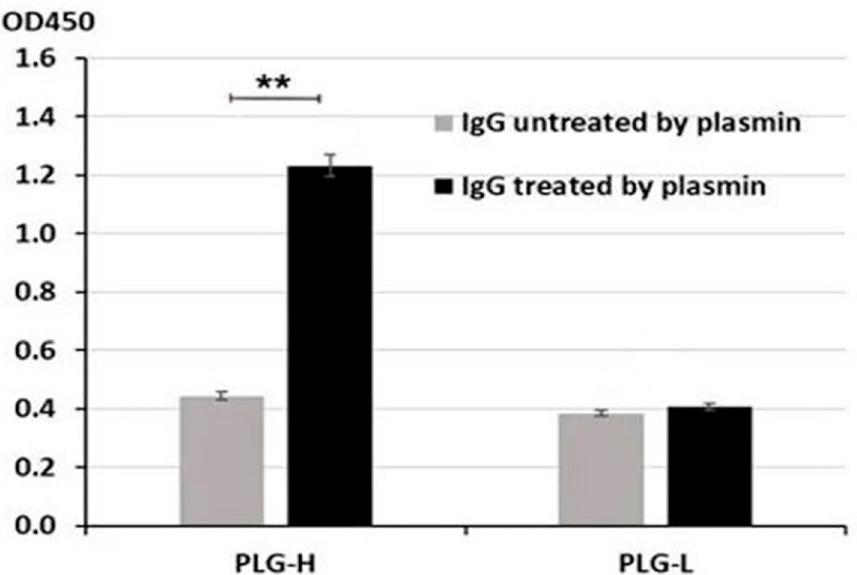
Figure 3. Binding of untreated or PM-proteolyzed purified IgG to PLG-H and PLG-L was evaluated as in Figure 1. The experiment was repeated 3 times. **, p < 0.01, not indicated–not significant.